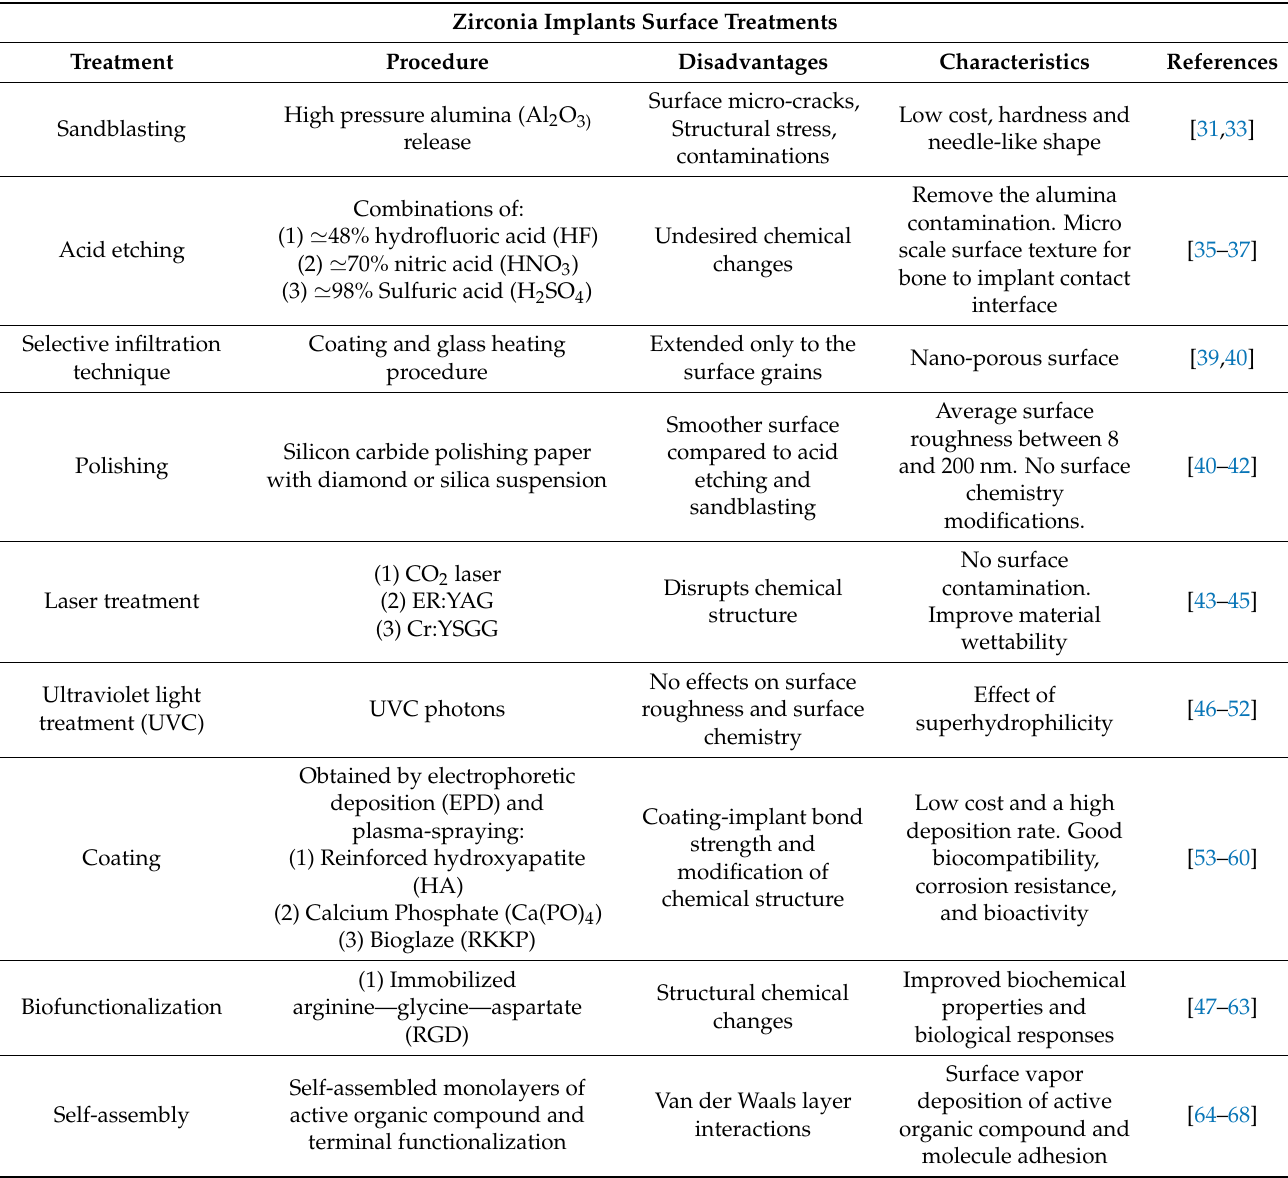
Figure 2. Scheme demonstrating the process of SAMs formation. Detailed chemical parts of the sur- face functionalization (i, ii and iii). Reprinted with permission under Creative Commons Attribution 4.0 International License, reference [65]. Table 1. Summary of the current chemical and physical treatments for zirconia implant